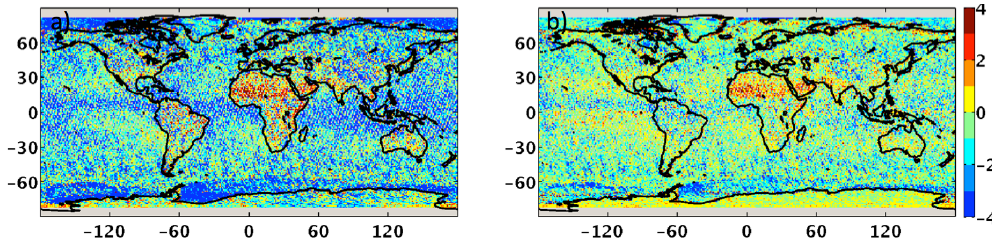
Figure 18. TOA SW flux error (Wm − 2 ) caused by scene identification uncertainty (standard – enhanced) (a) only using near-nadir viewing geometries, (b) using extended viewing geometries that are similar to the CERES observations.